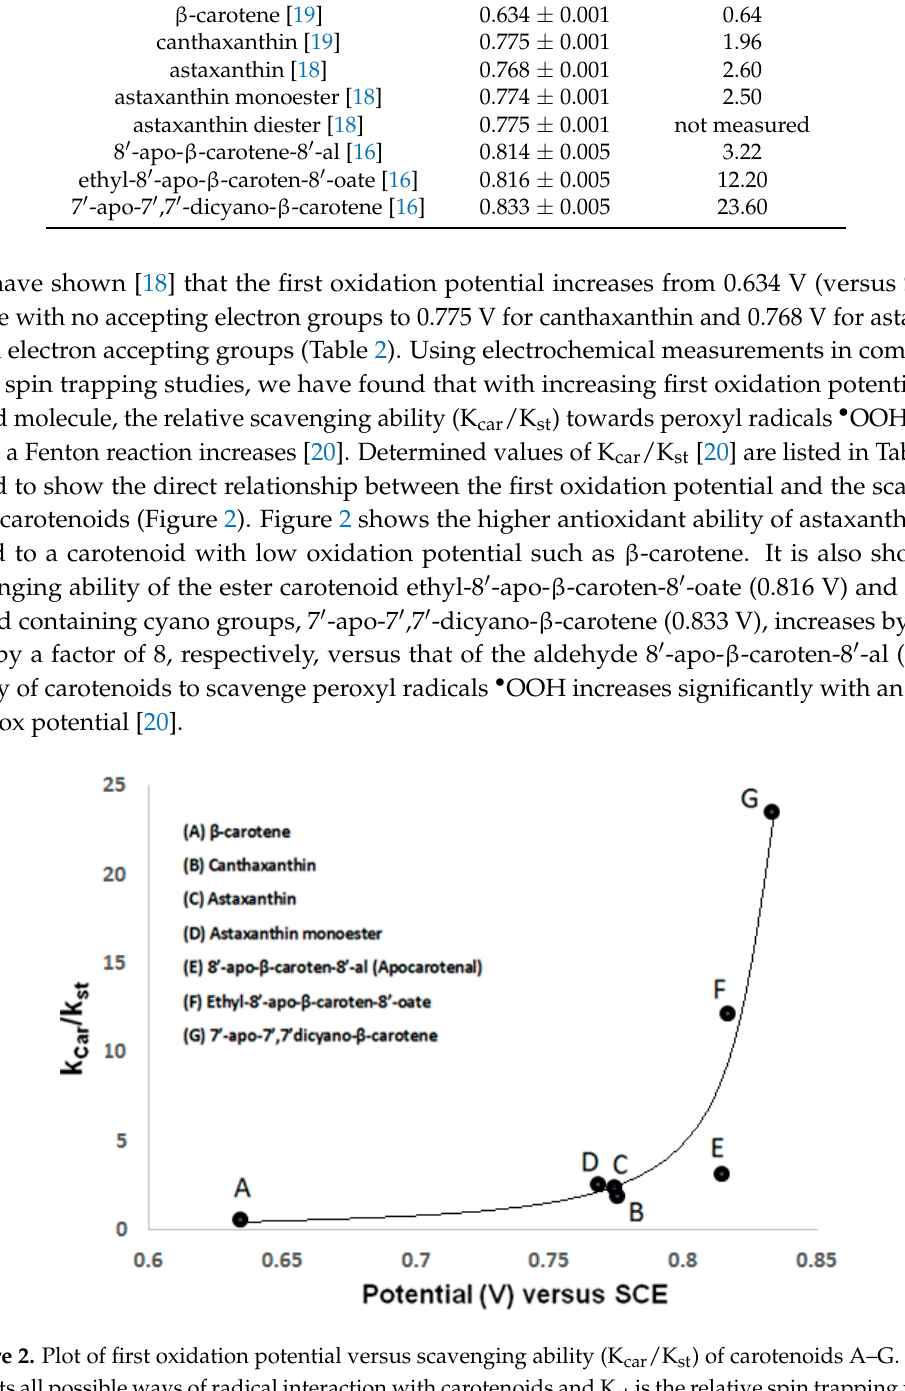
Table 2. First oxidation potentials ( E 0 (K car /K st ) towards peroxyl radicals.